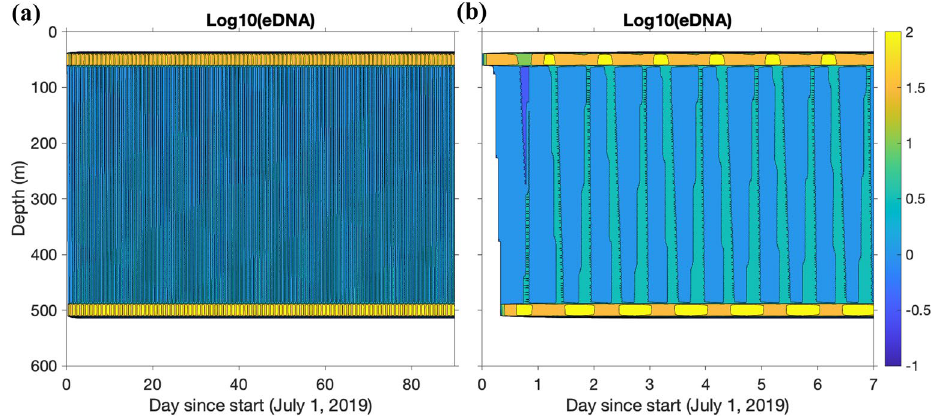
Figure 3. Temporal evolution of the eDNA concentration vertical profile in a representative simulation. Here, a summer (JAS) simulation with 50% of individuals migrating is shown. The eDNA concentration is log 10 transformed, and it is primarily a vertical bimodal distribution with peaks centered around the day depth (500 m) and the night depth (50 m). Diurnal variability (orange vs. yellow) induced by organism migration can be seen at 50 m and 500 m. Panel a) shows the whole 90-day simulation and panel b) shows the first 7 days of the same simulation.